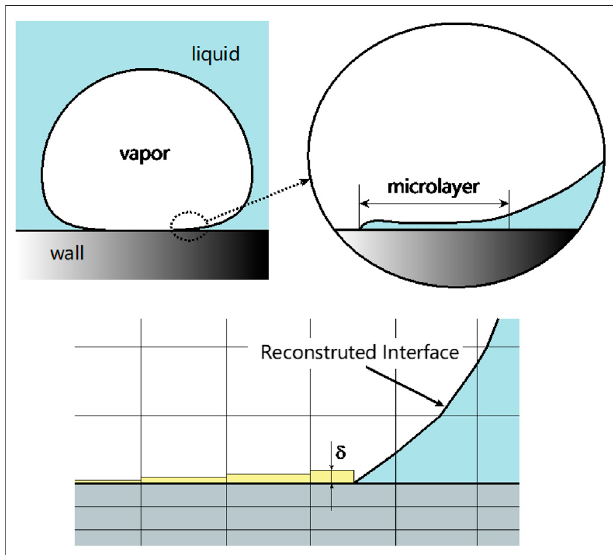
FIGURE 2 | A depletable microlayer model